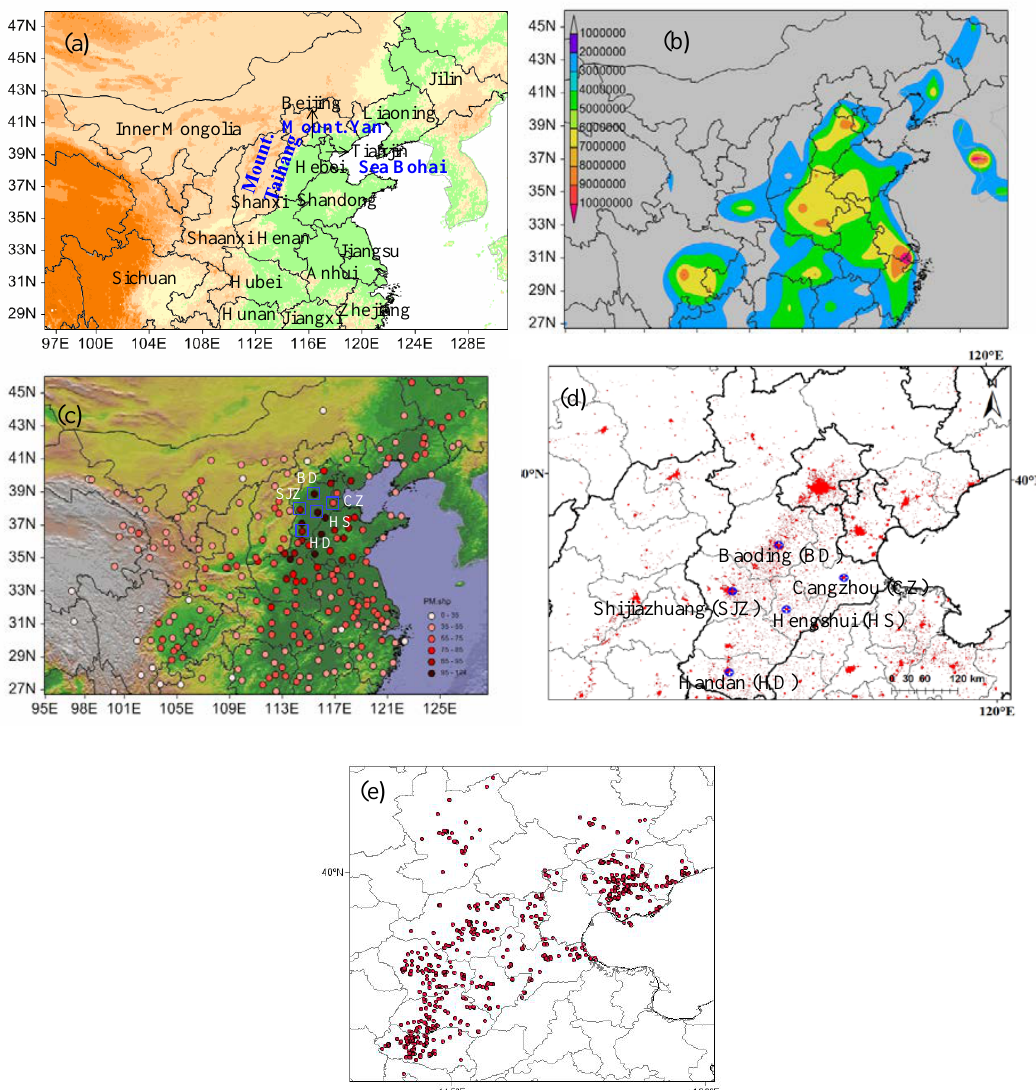
Figure 1. Topography ( a ), population count ( b ), and PM 2.5 concentrations in 2015 ( c ) over the east of China, the locations of the five cities in the south of North China Plain ( d ), main industries and enterprises emitting exhaust gases in Hebei Province from the MEPC ( e ). Note: the blue squares in ( c ) represent the five cities in this study; the red regions, black lines, and gray lines in ( d ) represent the urban area, province boundary and prefecture boundary, respectively. The population data were downloaded from http://sedac.ciesin.columbia.edu/data/set/gpw-v3-national-identifier-grid.